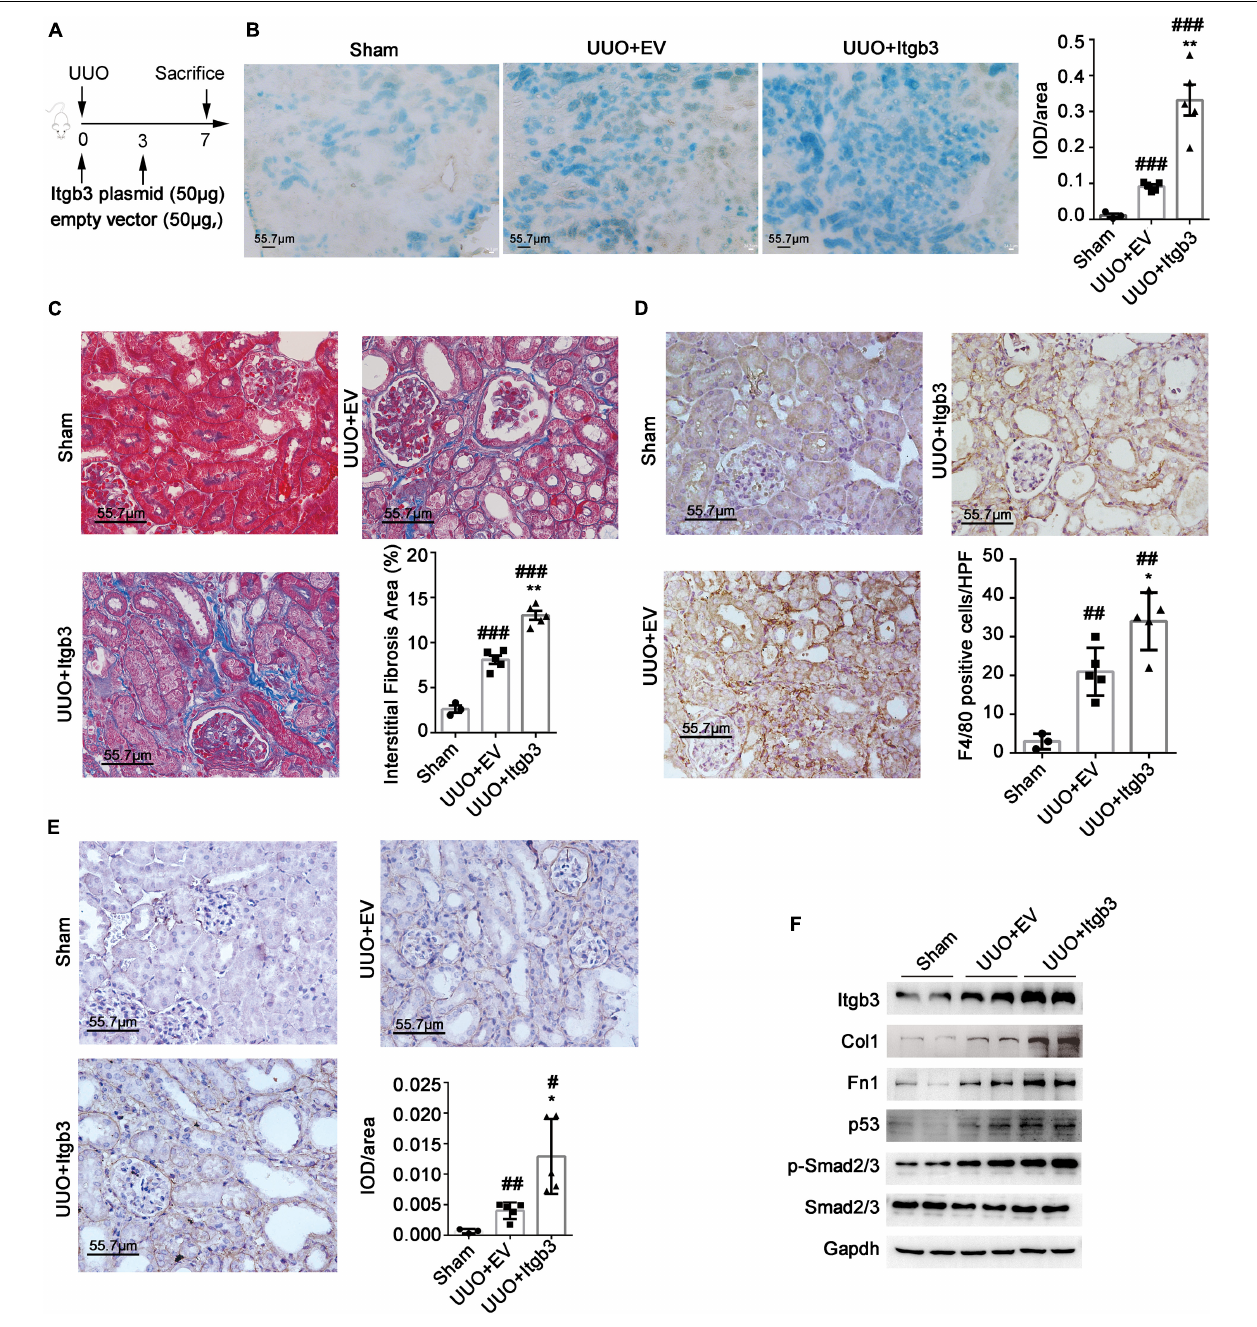
FIGURE 5 | Integrin β 3 (ITGB3) overexpression aggravates UUO nephropathy in mice. We injected the Itgb3–expressing plasmids or control plasmids into mice via tail injection. (A) Schematic diagram of the experimental procedure. Representative images of (B) SA- β -gal, (C) Masson trichrome, (D) F4/80, and (E) Fn1 staining of mouse kidneys (day 7 post-UUO, n = 5 for UUO + EV and UUO + ITGB3 group, n = 3 for Sham group). Right histogram represents quantitative analysis of staining. (F) Expression of Itgb3, p53, Smad2/3, pSmad2/3, Col, and Fn1 in renal tubule from UUO mice injected with Itgb3-expressing or EV plasmid and Sham mice. For statistical analysis, a two-tailed Student’s t -test was used for panels (B–E) . * p < 0.05; ** p < 0.01 when compared with the EV group; # p < 0.05; ## p < 0.01; ### p < 0.001 when compared with the Sham group; EV, empty control. Scale bar = 55.7 µ m.